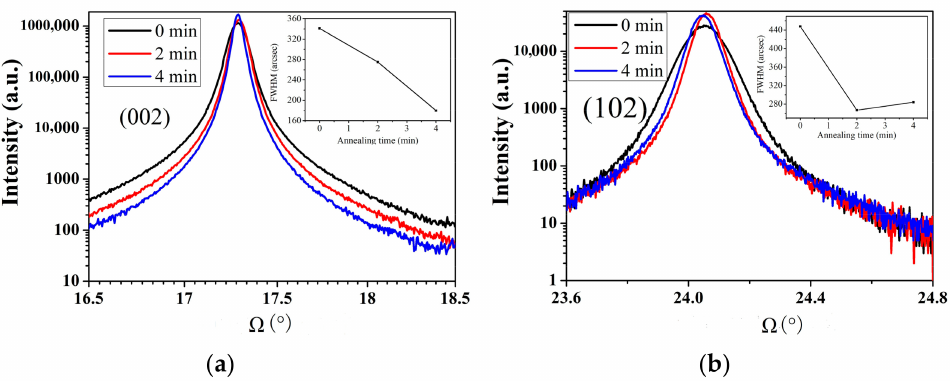
Figure 4. The rocking curves of ( a ) (002) and ( b ) (102) planes of bulk GaN with 0, 2 and 4 min annealing time and the insert corresponds to their